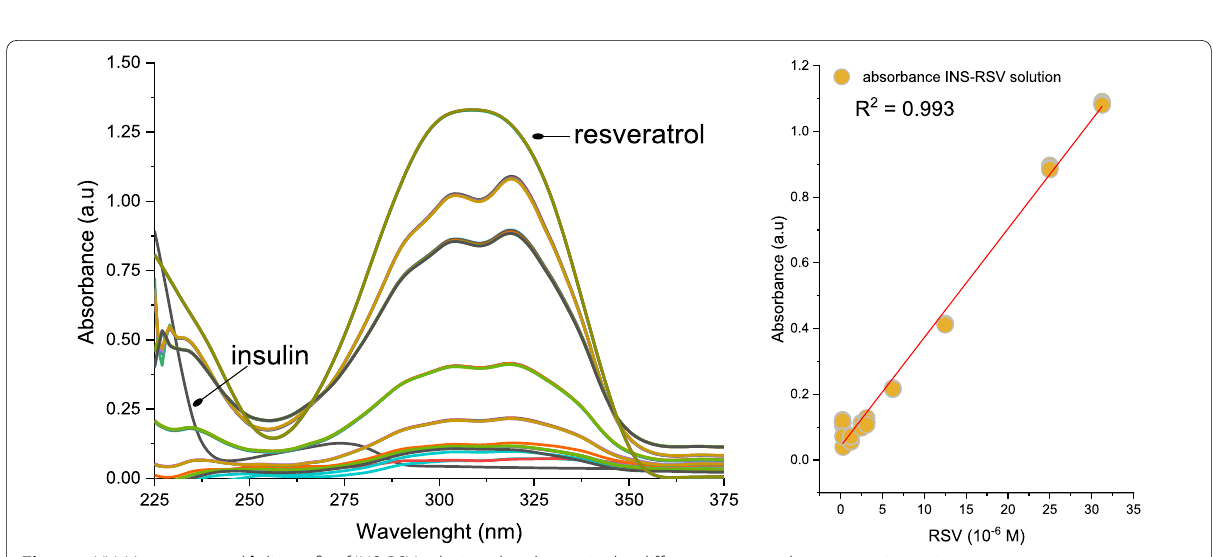
Fig. 5 a UV–Vis spectra and b linear fit of INS‑RSV solution absorbance in the different resveratrol concentration